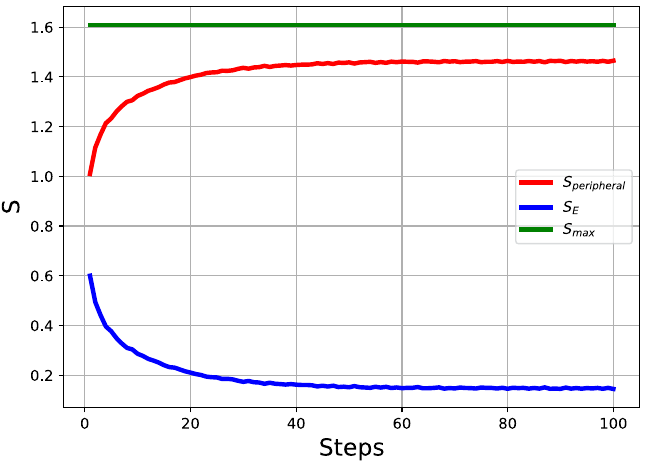
Figure 4. The average of the three entropy traces for the system simulations are shown S max , S E , and S peripheral . The green line shows the S max value is constant which aligns with the theoretical calculation for the entropy of the system, in blue S E the entropy of the political engagement and in red the entropy of non-politically aligned actions S peripheral . This simulation has a fixed number of 5 actions ( n total = 5 ) for the agents to participate in per time